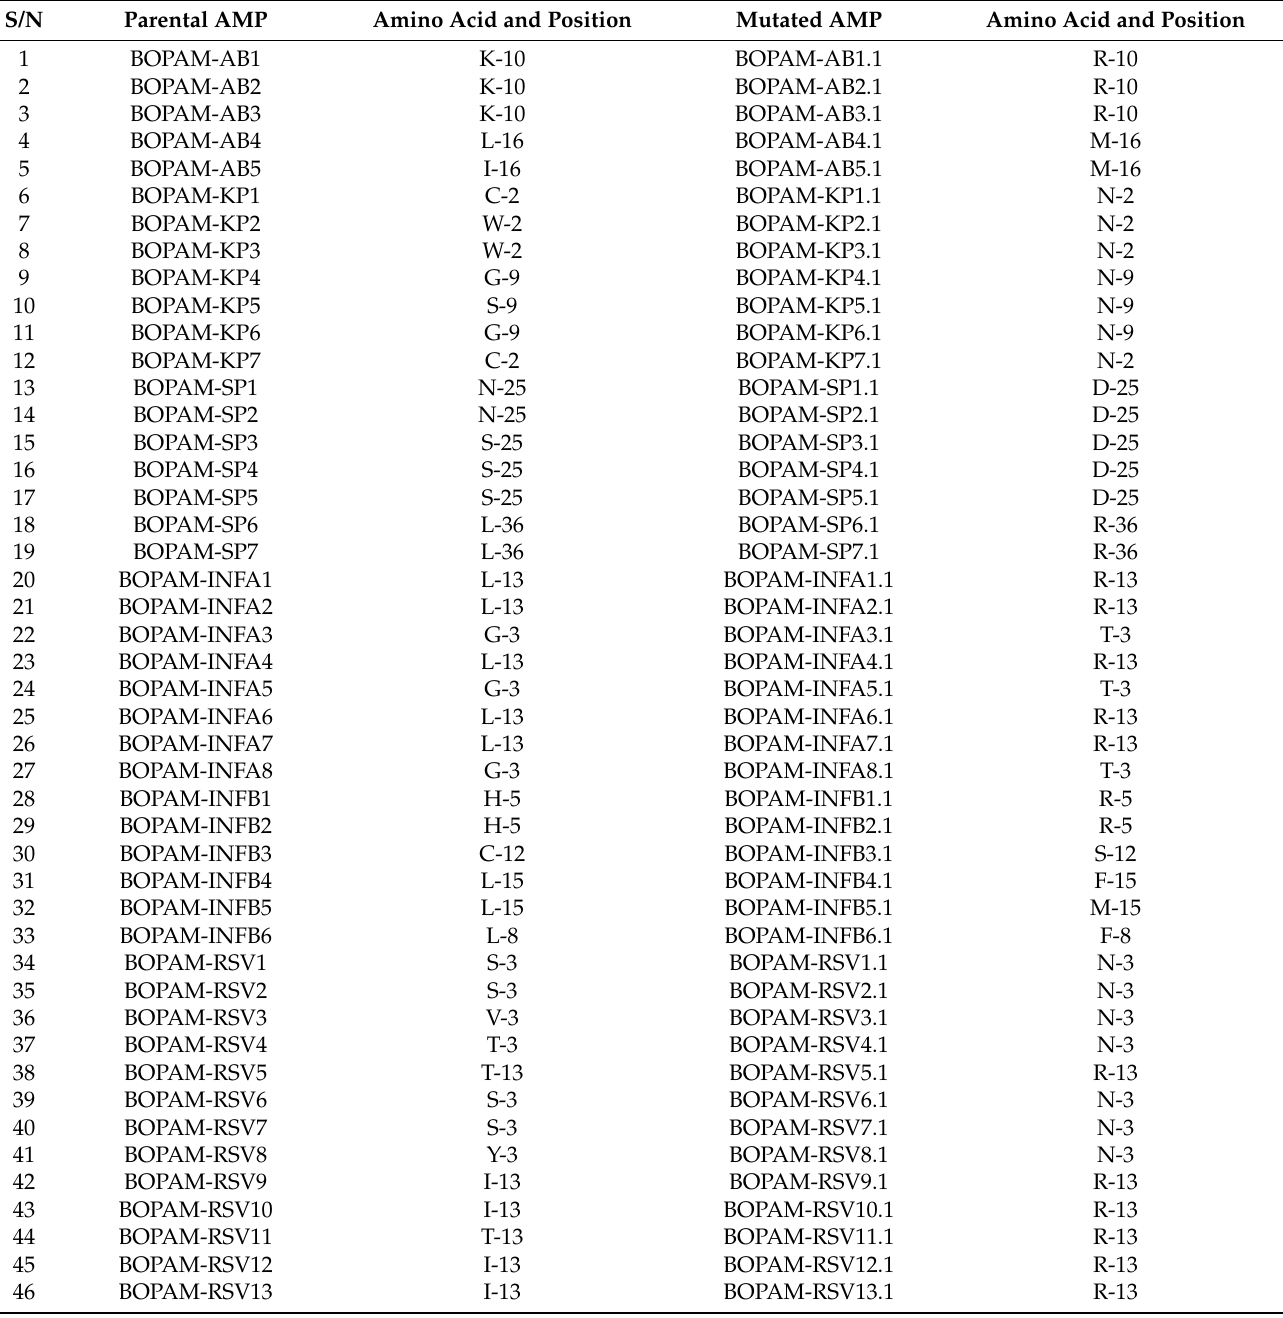
Table 2. Site-directed mutagenesis of the anti-pneumonia